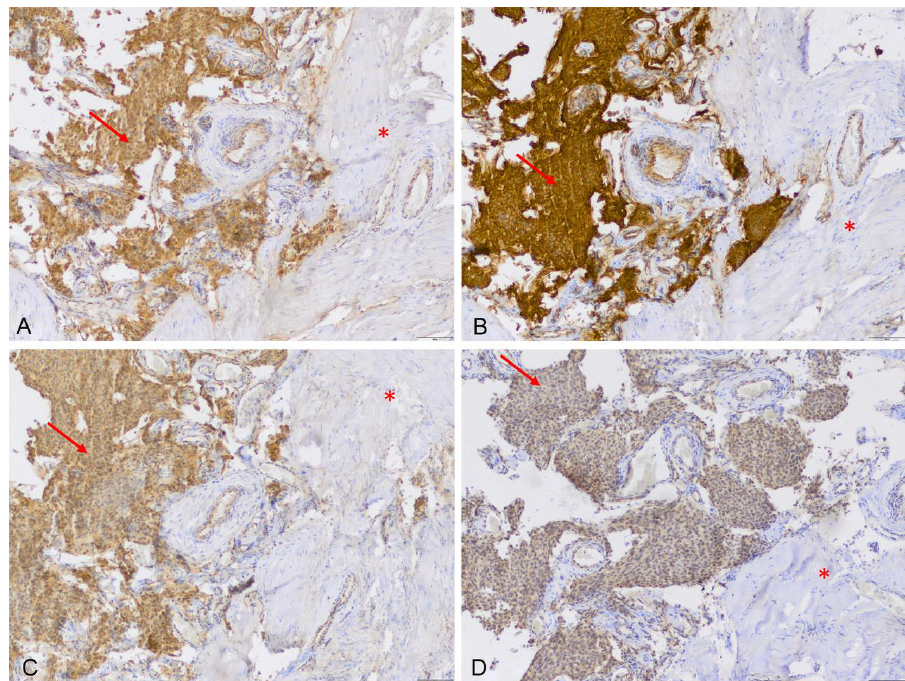
Figure 2. Illustrative samples of expression of the analyzed transporters and metabolism enzymes in the dura attachment of a meningioma, taken using immunohistochemistry. Expression of ABCB6 ( A ), ABCG2 ( B ), FECH ( C ) and CPOX ( D ) was found in tumor tissue (arrows) but not in the adjacent dura mater (*, scale bar 100 µm, magnification 10-fold).